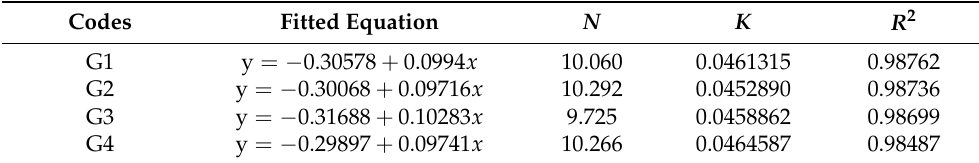
Figure 8. Kondo equation piecewise fitting hydration deceleration stage (EF stage); ( a ) G1, ( b ) G2, ( c ) G3, ( d ) G4. Table 7. Results of Kondo equation piecewise fitting hydration deceleration stage.